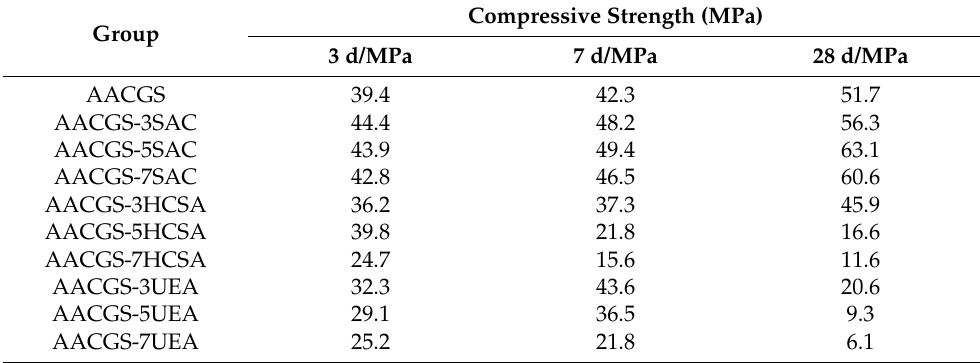
Table 5. Effect of expansive additives on compressive